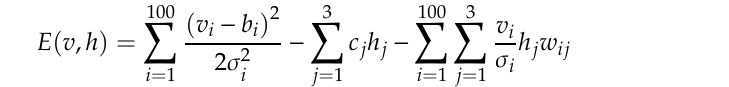
Table 2. Details of the hyper-parameters of the used deep belief network (DBN) network. Hyper Parameter Designation v i = {1, 2, ... ,100} Value of node i in the visible layer Value of node j in the hidden layer b i , c j : bias associated with the i th visible node and j th hidden node, respectively. w ij The weight between the visible units i and hidden units j σ 2 the covariance for the i th distribution i batch 64 Size of hidden layer